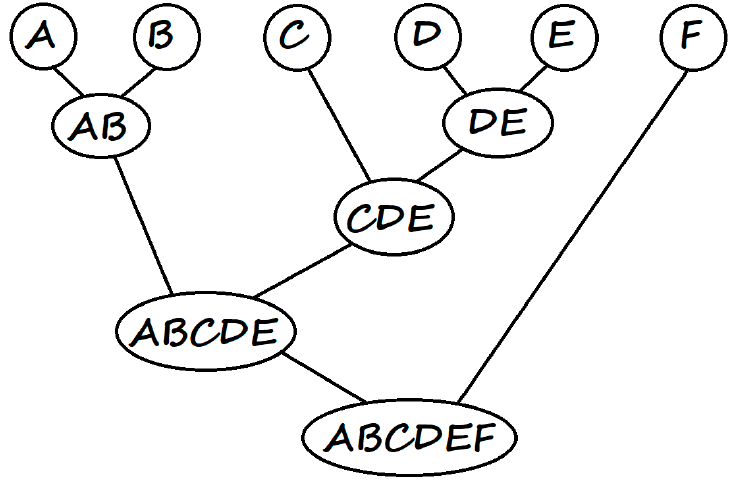
Figure 4. Hierarchical clustering.